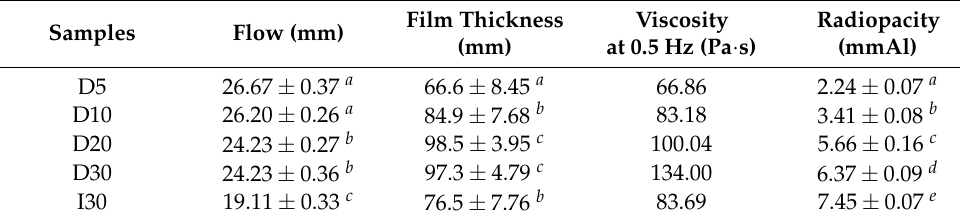
Table 1. Flow, film thickness, viscosity at 0.5 Hz, and radiopacity of the samples (mean ± SD). Samples